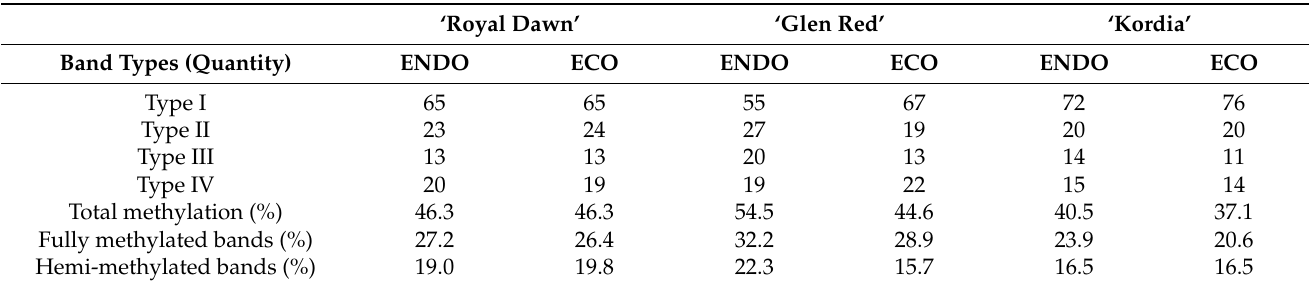
Table 2. Changes in DNA methylation patterns in floral buds of ‘Royal Dawn’, ‘Glen Red’, and ‘Kordia’ sweet cherry varieties at endodormancy (ENDO) and ecodormancy (ECO). ‘Royal Dawn’ ‘Glen Red’ ‘Kordia’